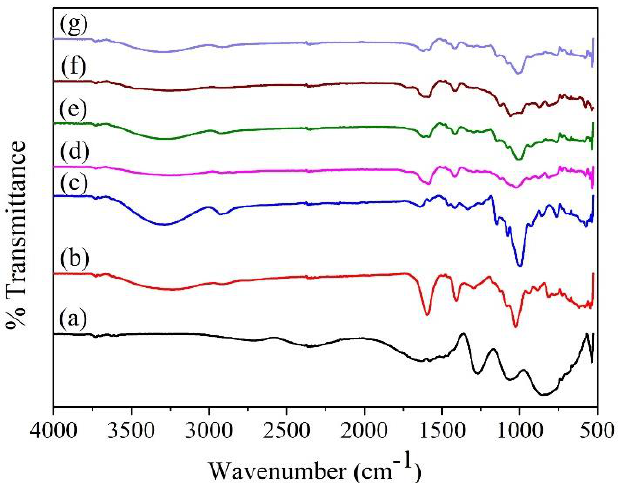
Figure 3. FTIR spectra of ( a ) KH 2 PO 4 , ( b ) alginate, ( c ) starch, ( d ) PHBs-DI, ( e ) PHBs-pH = 5, ( f ) s- PHBs-DI, and ( g ) s-PHBs-pH = 5.